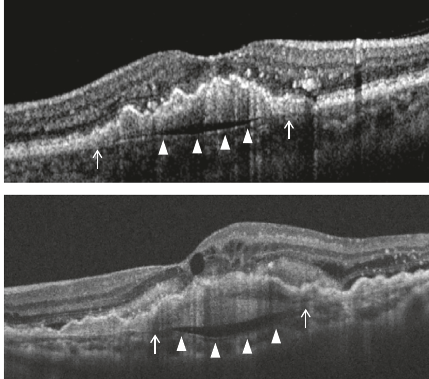
Figure 1: Representative images showing prechoroidal cleft (ar- rowheads), which developed during the treatment course of type 3 neovascularization. Note that the subretinal pigment epithelial tissue attaches to the Bruch’s membrane at the edge of the cleft